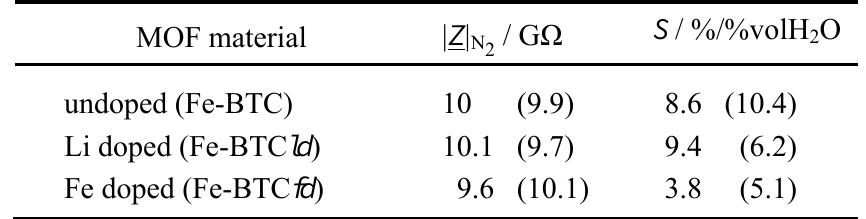
carrier gas for differently doped Fe-BTC materials at 120 °C. Table 3. Impedance | Z | in N 2 For each material composition, two equally prepared sensors were compared at 1